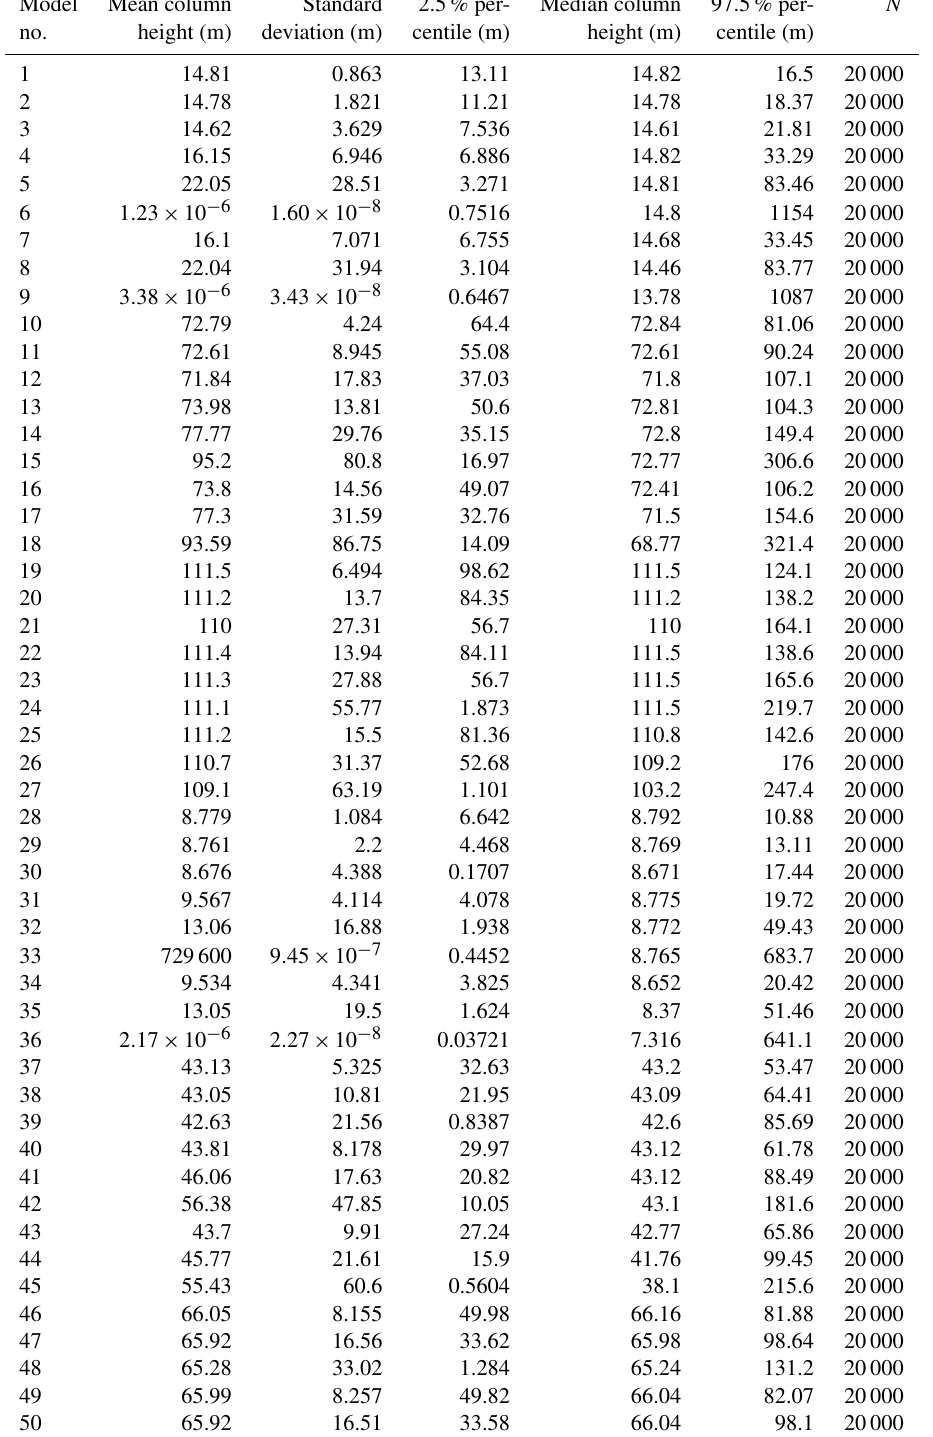
Table 2. Table showing the results of the MCMO models defined in Table 1.